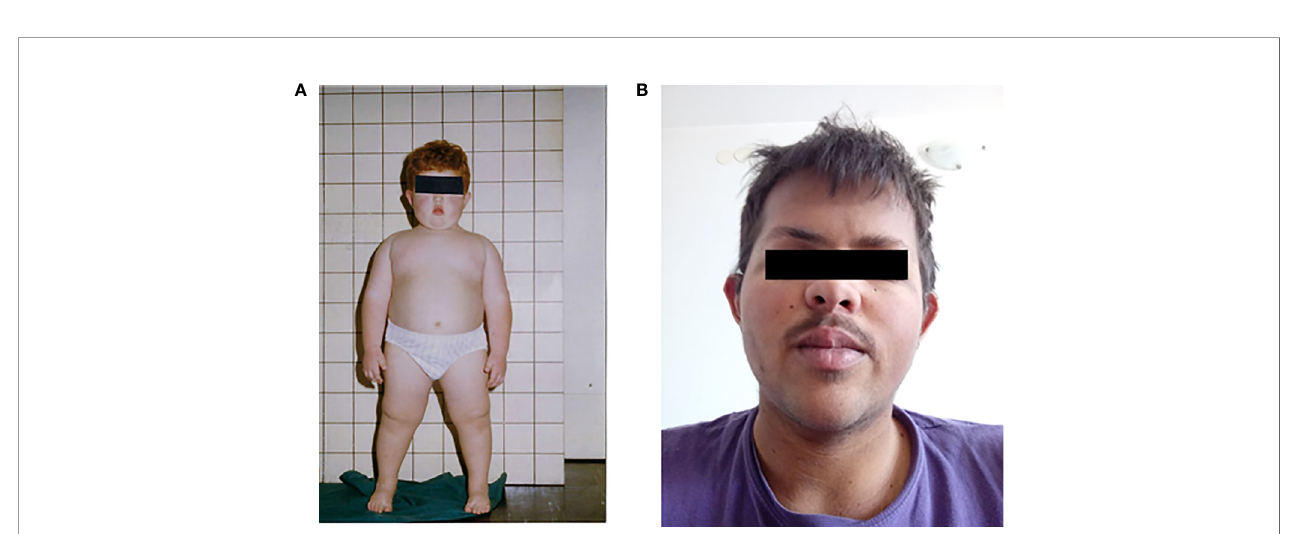
FIGURE 3 | Case patient 1 in childhood, before setmelanotide treatment (A) and after (B) .